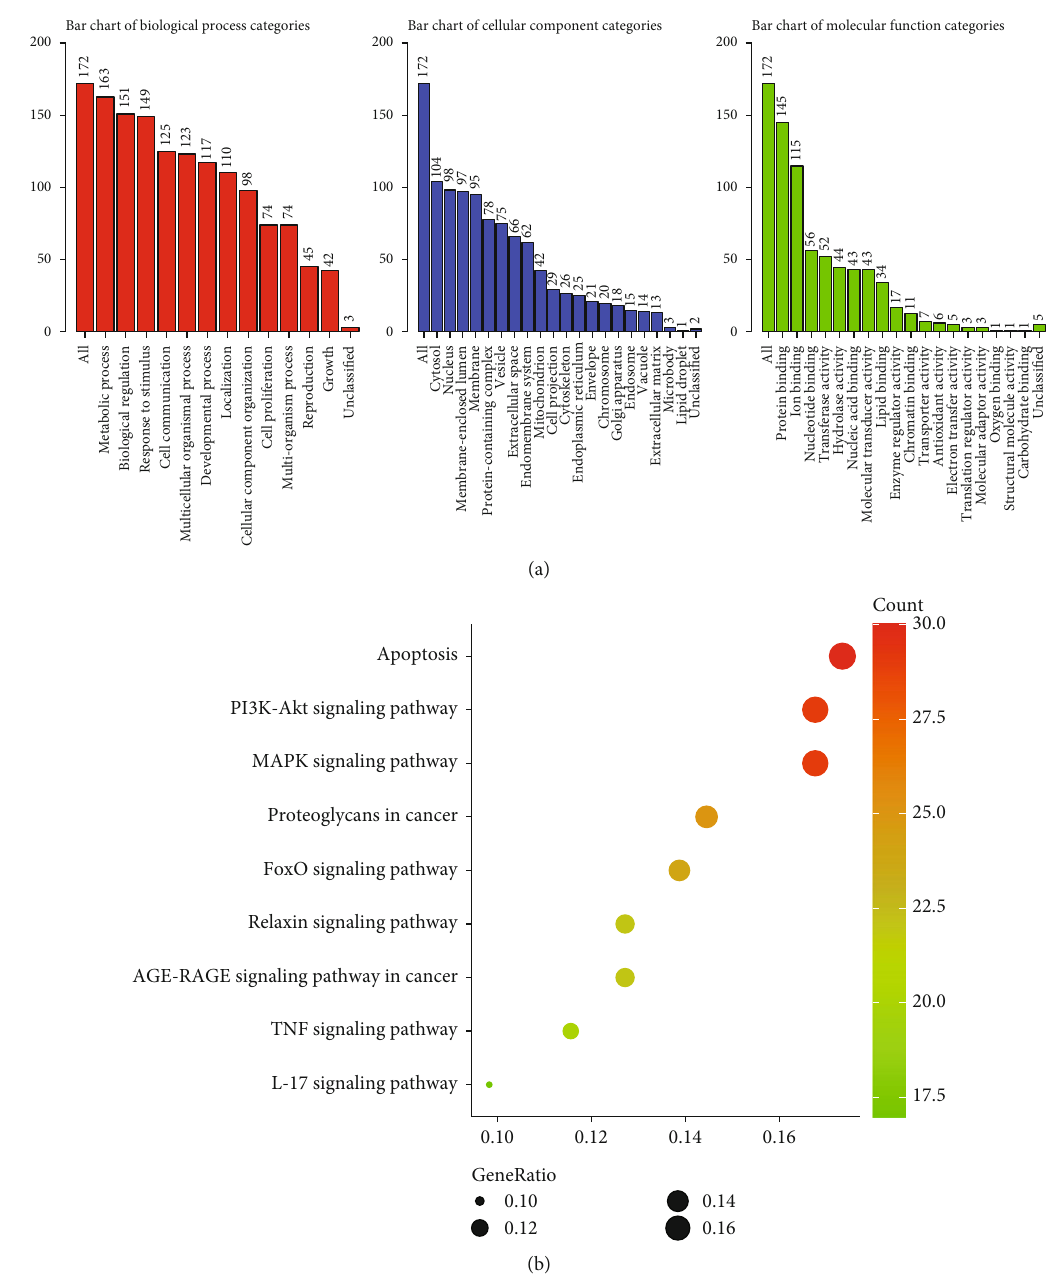
Figure 5: (a) GO functional enrichment analysis of osthole in gastric cancer. (b) KEGG pathway enrichment analysis of osthole in gastric